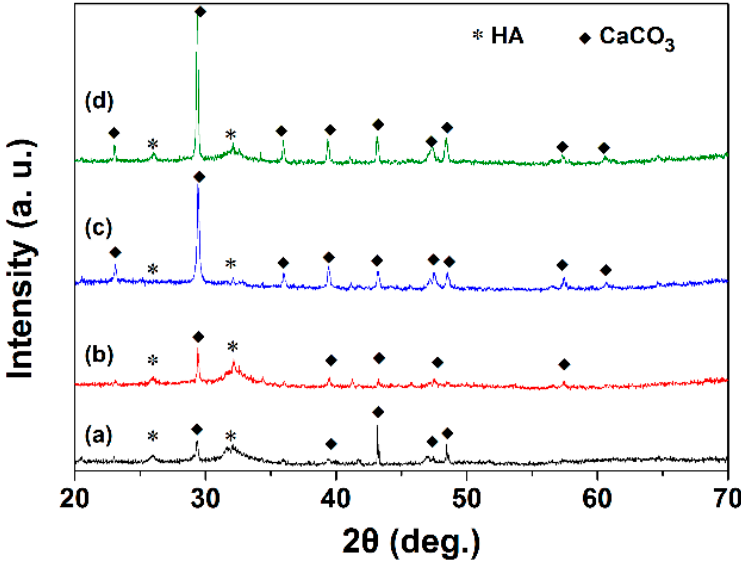
Figure 9. XRD patterns of C2S and Sr-C2S bone cements after immersion in SBF solution for 7 days: ( a ) C2S; ( b ) Sr1-C2S; ( c ) Sr5-C2S; ( d ) Sr10-C2S. The results suggest apatite formation on all C2S and Sr-C2S bone